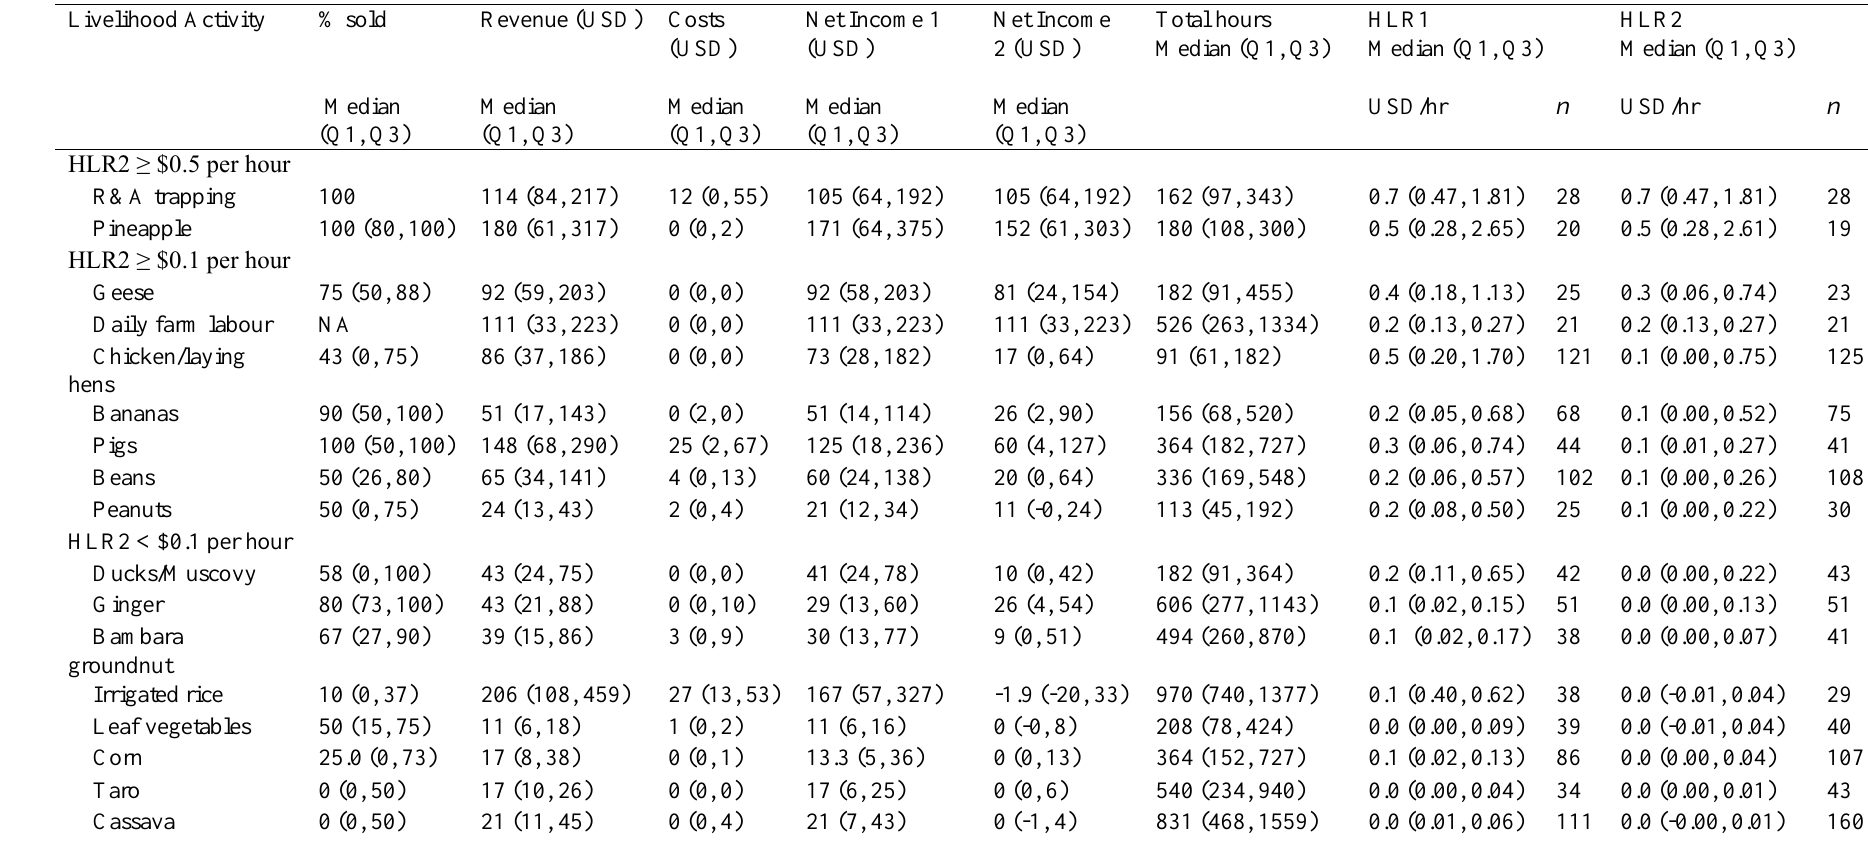
Table A5.1. Evaluation of ‘Household Livelihood Return’ (HLR) for livelihood activities carried out by households in the Moramanga district of